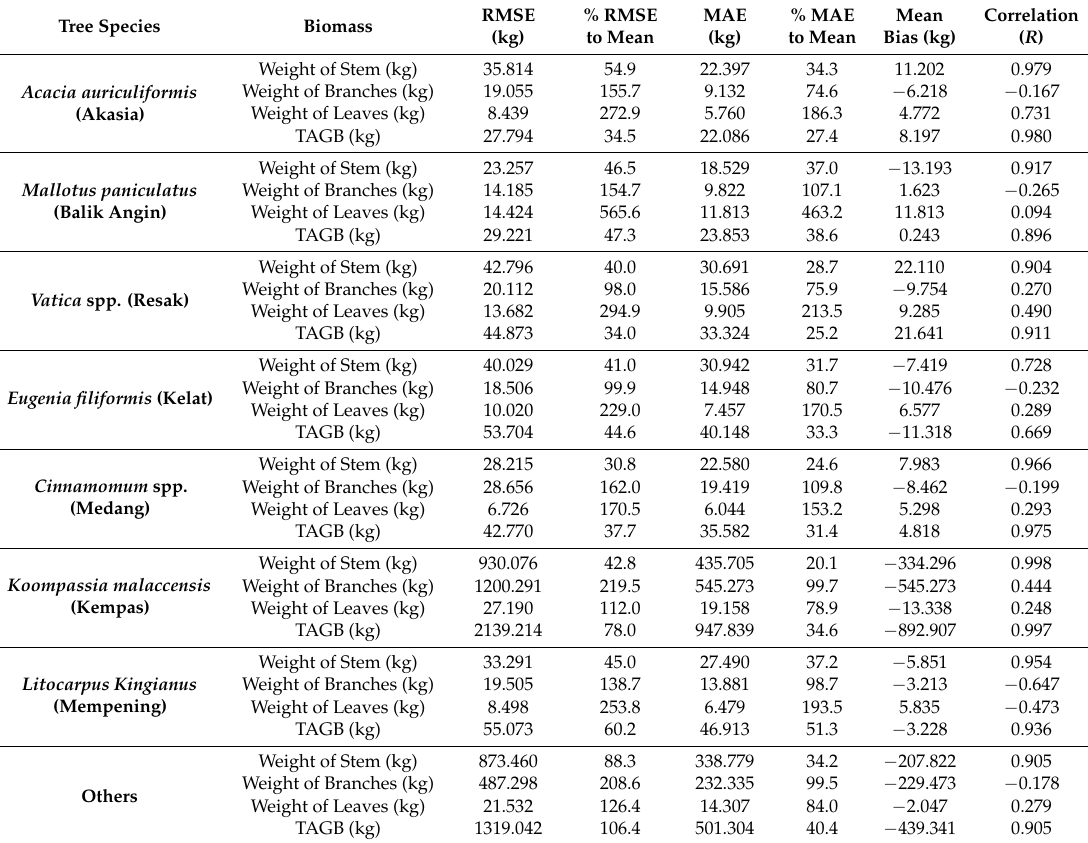
Table 5. Assessment of biomass from different compartments and total aboveground biomass of different tree